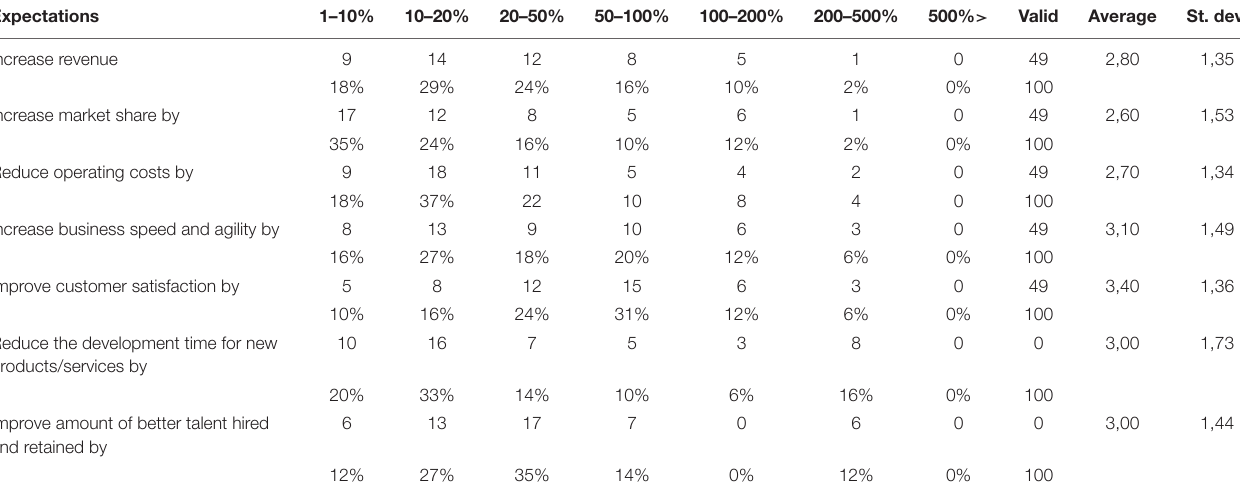
TABLE 1 | Results of participants’ SME achievement expectations by introducing disruptive innovation.